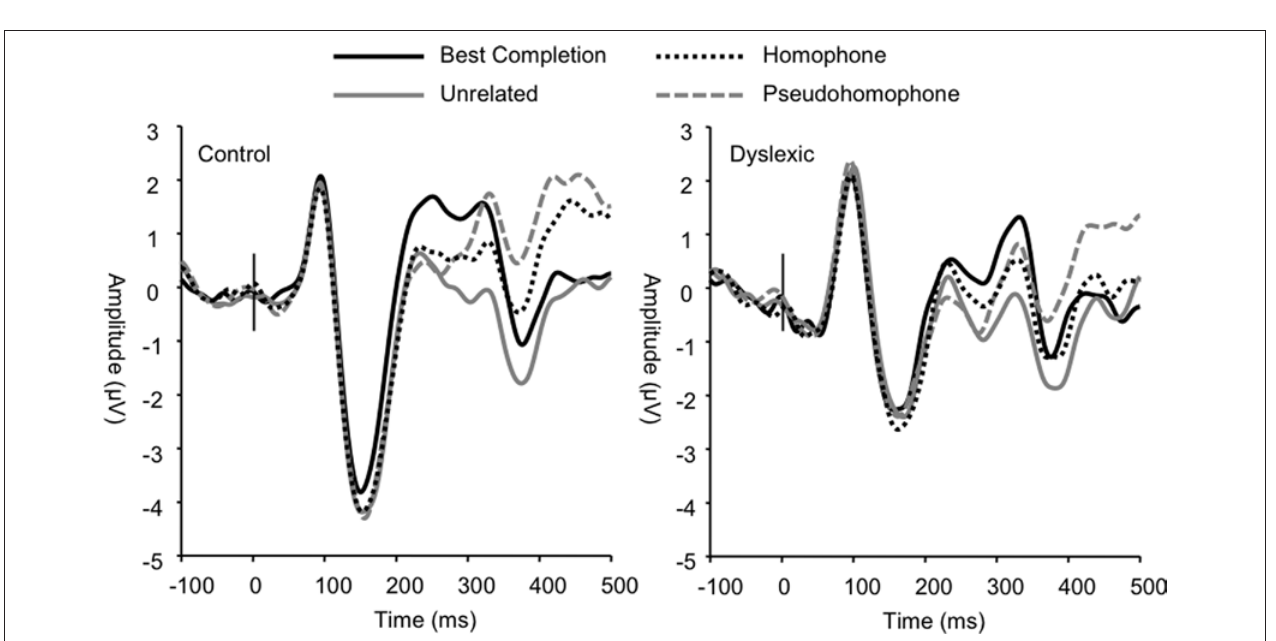
FiGure 3 | Group effect on N1 amplitude. Linear derivation of O1, O2, P7, and P8 electrodes. Note negative amplitudes are plotted